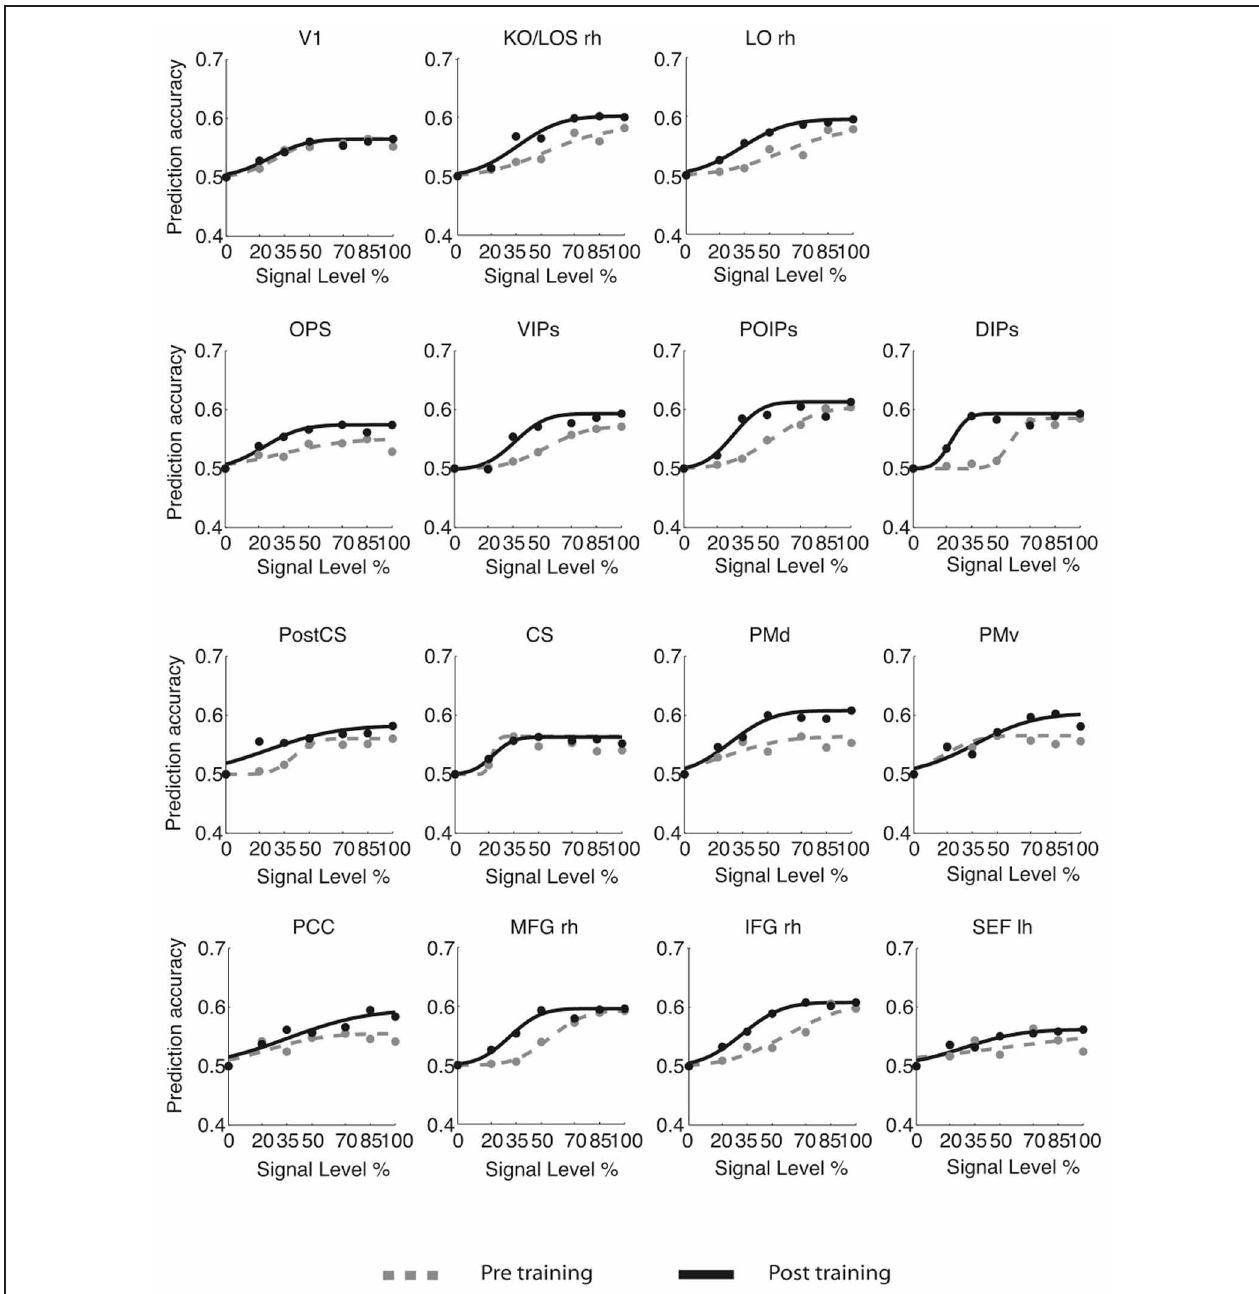
FIGURE 3 | fMR-metric functions for young adults. fMR-metric functions are shown for each ROI, for both pre- (gray dotted lines) and post-training (black solid lines) sessions. Plotted data points depict the